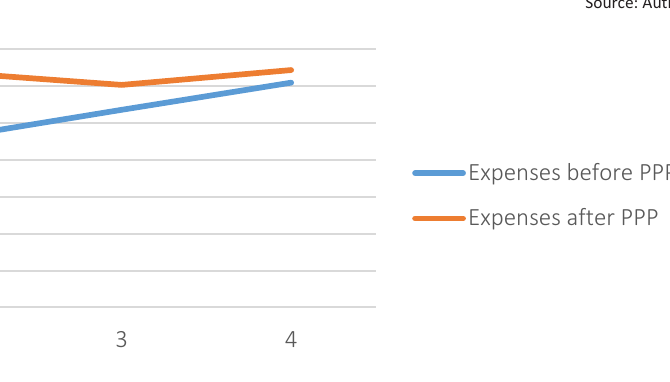
Figure 1. Distribution of total costs before and after privatization